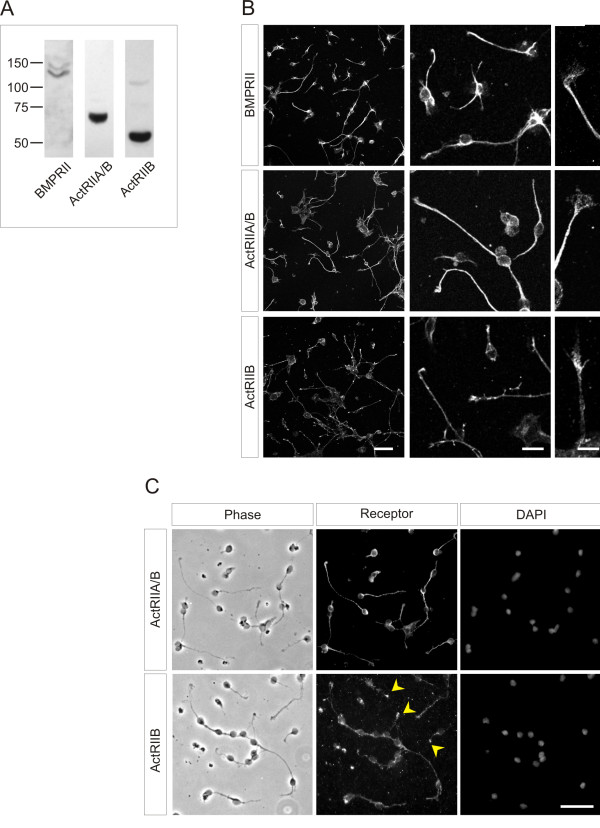
Type II BMP receptor expression in dI neurons. (A) Western analysis of whole cell lysates of dissociated dI neurons probed with α-BMPRII (130 kDa, lane 1), α-ActRIIA/B (70 kDa, lane 2) and α-ActRIIB (58 kDa, lane 3) antibodies. (B) Immunofluorescence labeling of dissociated dI neurons with antibodies against type II BMP receptors (α-BMPRII, α-ActRIIA/B and α-ActRIIB). The left column shows relative numbers of labeled neurons against background low level fluorescence (scale = 50 μm). The center column (scale = 20 μm) and right column (scale = 10 μm) highlight neuronal detail. (C) Direct comparison of ActRIIA and ActRIIB expression in sister cultures. Phase contrast (left), BMP receptor immunofluorescence labeling (center) and DAPI nuclear staining (right) of dissociated dI neurons. Arrowheads indicate ActRIIB+ growth cones. Analysis of immunofluorescence label for each antibody from three to four 20 × fields showed that 85.6 ± 3.7% of 1,056 total neurons were ActRIIA+ (n = 4), 33.1 ± 3.7% of 732 total neurons were ActRIIB+ (n = 4) and 78.6 ± 3.3% of 465 total neurons were BMPRII+ (n = 3). Scale = 50 μm.